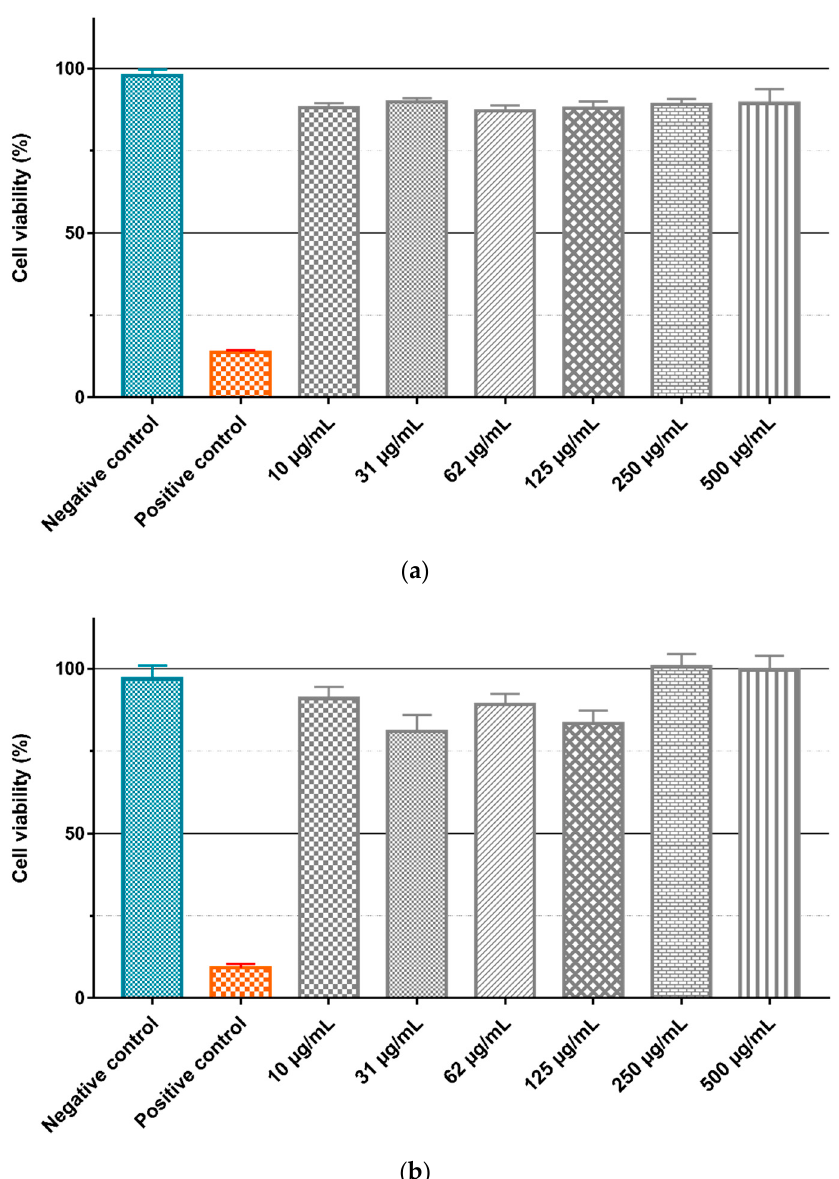
Figure 18. Evaluation of nanoparticle cytotoxicity by the MTT method. The GL261 tumor cell line was treated for 24 h in a suspension containing different concentrations of ( a ) Gd 2 O 3 :Eu 3+ and ( b ) SiO 2 -Gd 2 O 3 :Eu 3+ (1%) nanoparticles. The graphics represent the mean values + standard deviation of the mean of ( a ) four independent experiments and ( b ) three independent experiments. Negative control: cells in medium only. Positive control: cells treated with ( a ) 0.4% ( v / v ) Triton X-100 or ( b ) 0.5% ( v / v ) Tween 20.